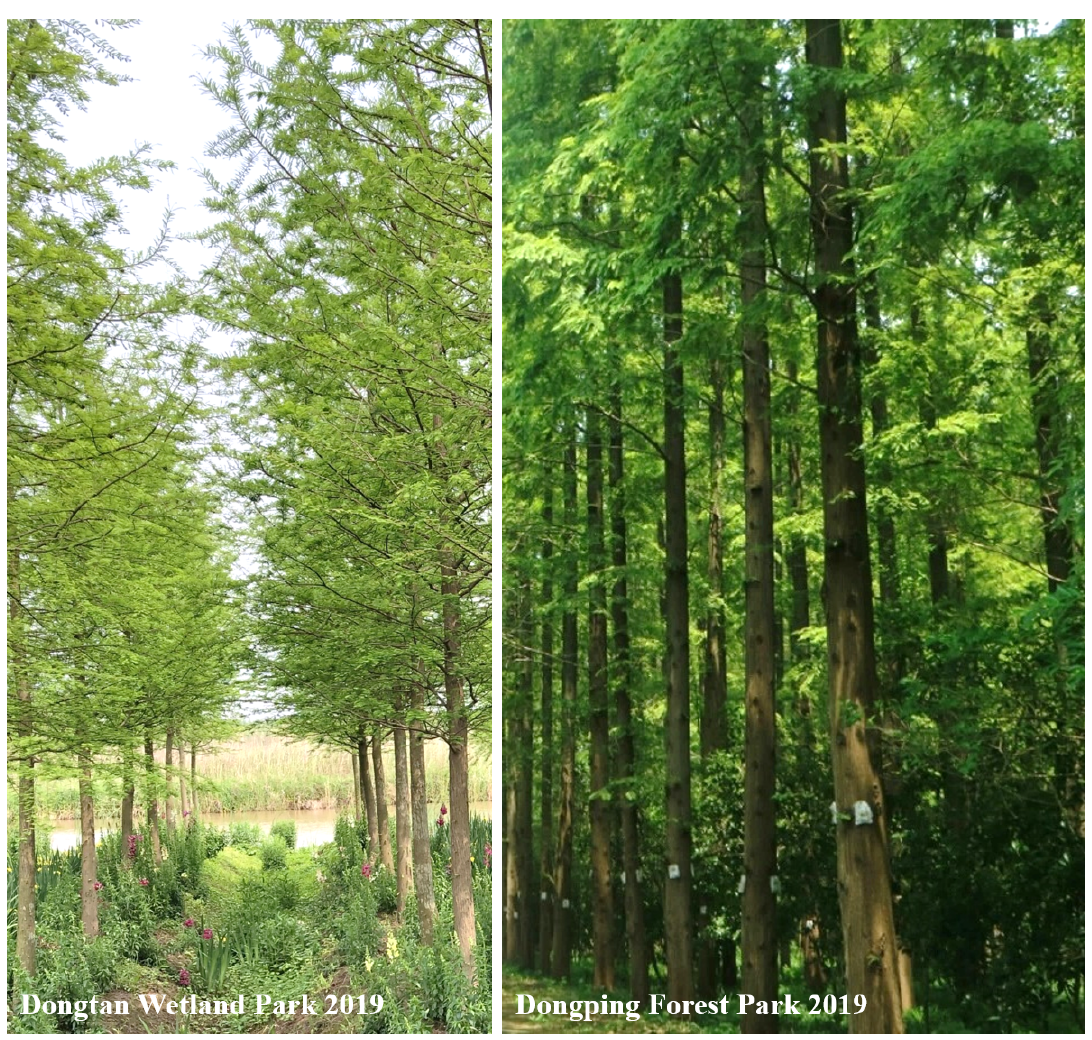
Figure 2. Metasequoias planted in wetland and forest park in Chongming